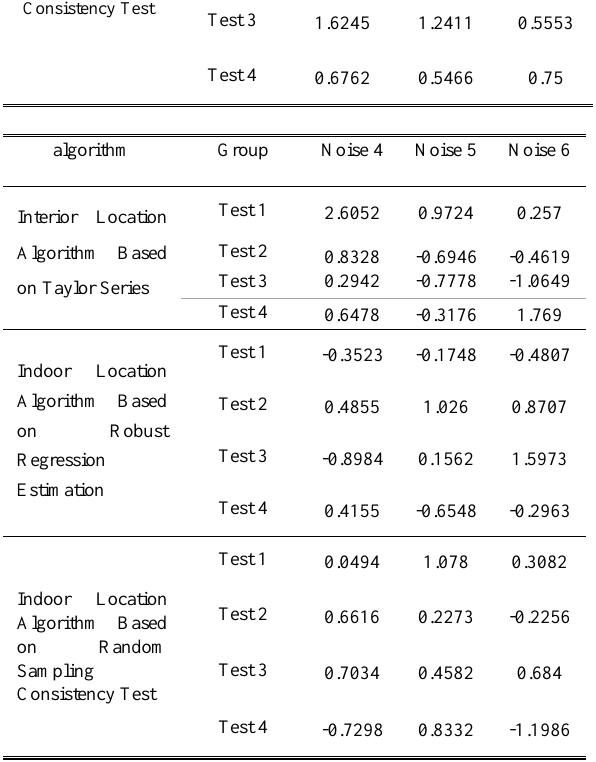
Table 4 Comparison of three algorithms for test data Gaussian noise